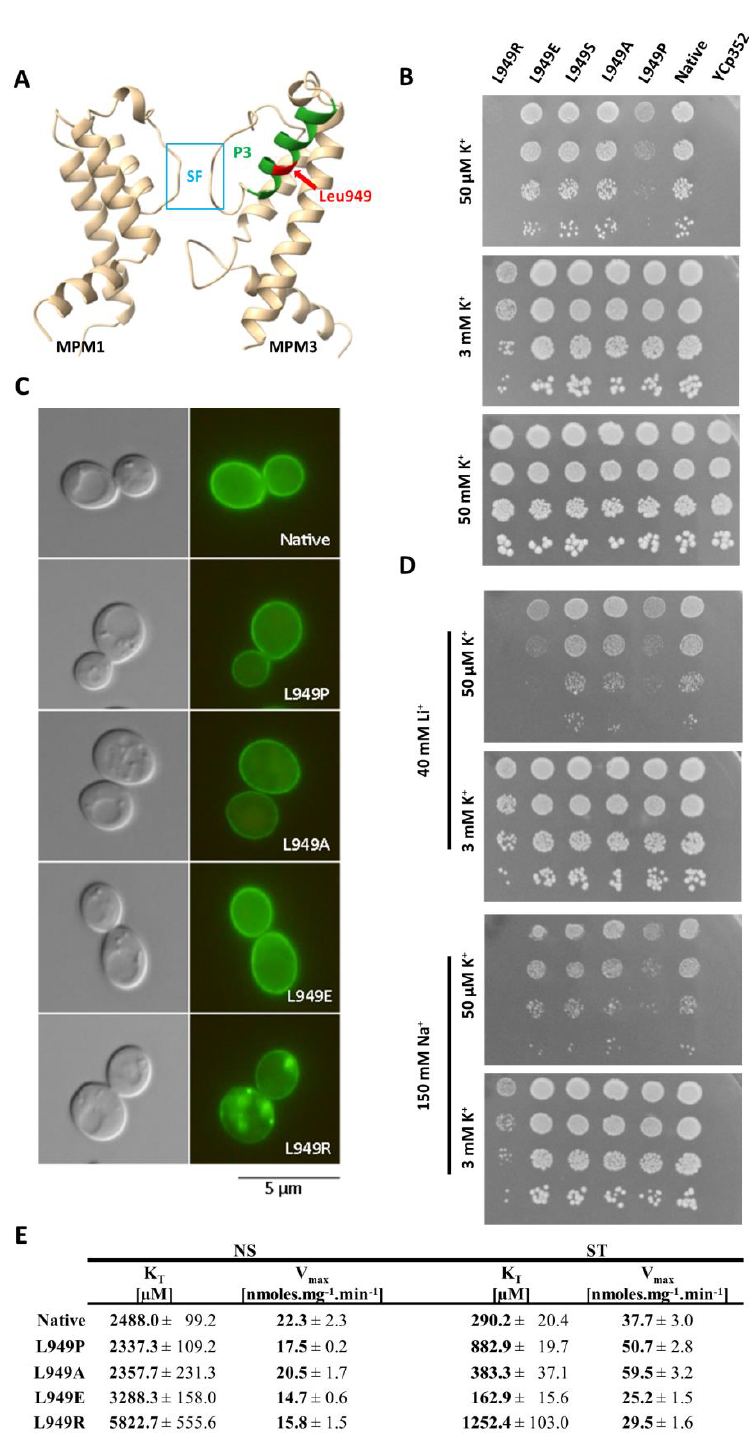
Figure 4. Effects of Leu 949 substitution. ( A ) Localization of Leu949 within a 3D model of Trk1 protein. P-helix 3 is shown in green, the position of Leu949 in P3 is highlighted in red, and the part of the selectivity filter (SF) in blue. For better clarity, only MPM domains 1 and 3 are shown. ( B ) Growth of BYT12 cells without TRK1 (BYT12[YCp352]) or with centromeric vector harbouring TRK1 (native) and its mutated versions on YNB-F plates supplemented with K + , as indicated. Images were captured after 5 days of incubation at 30 ◦ C. ( C ) Localization of GFP-tagged Trk1 and its mutated versions in BYT12 cells. Cells were grown and viewed as described in Section 2. ( D ) Growth of cells on YNB-F plates supplemented with indicated concentrations of K + , Na + and Li + . The order of strains and length of incubation were the same as in ( B ). ( E ) Kinetic parameters of native Trk1 and its